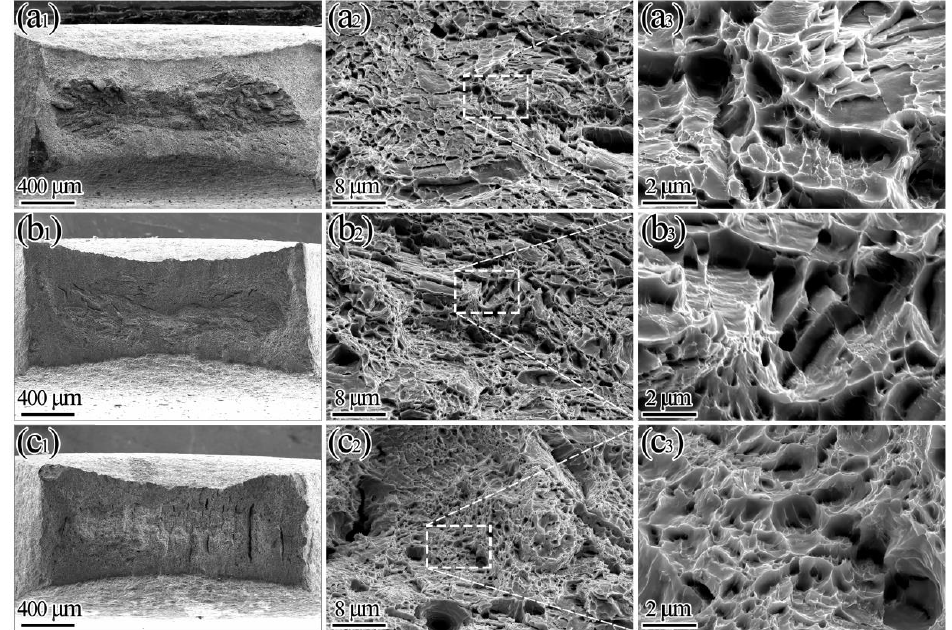
Figure 7. Overall macroscopic (first column), microstructure (second column) and local amplification (third column) of fracture morphology analysis of different tempering temperatures: ( a 1 – a 3 ) 550 °C (3 h) + 600 °C (2 h); ( b 1 – b 3 ) 625 °C (3 h) + 600 °C (2 h); ( c 1 – c 3 ) 675 °C (3 h) + 600 °C (2 h).